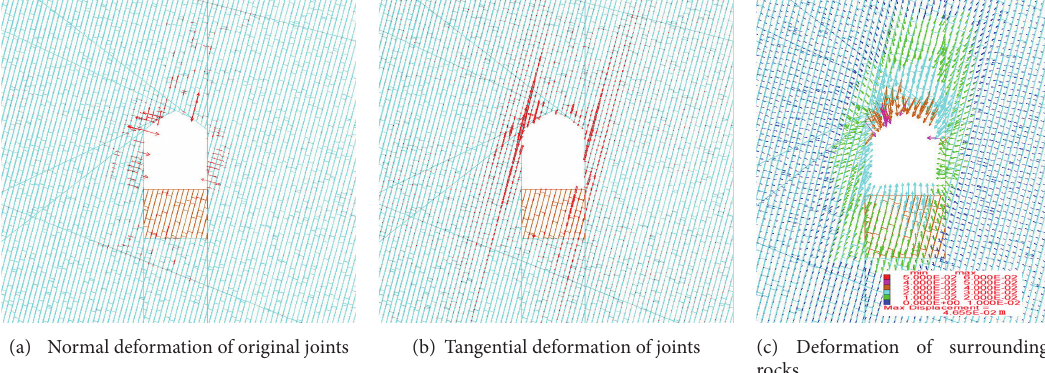
Figure 7: Numerical simulation results of the surrounding rock deformations.